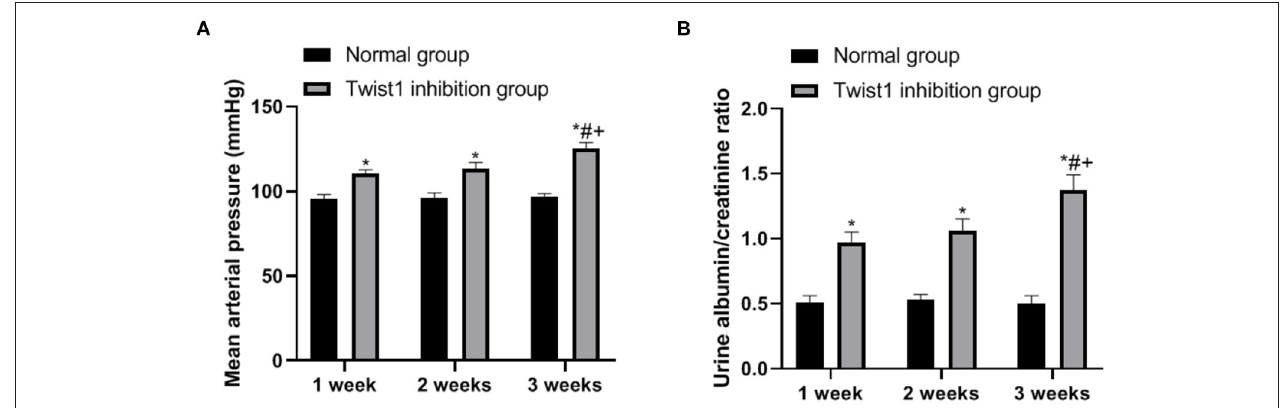
FIGURE 4 | The effect of inhibiting Twist1 on mean tail artery pressure and urine protein in female mice. (A,B) Detection of Mean Tail Arterial Pressure and Urine Protein in Female Rats; Compared with Normal group, * p < 0.05; compared with Twist1 inhibition group of 1 week, # p < 0.05; compared with Twist1 inhibition group of 2 week, + p < 0.05.